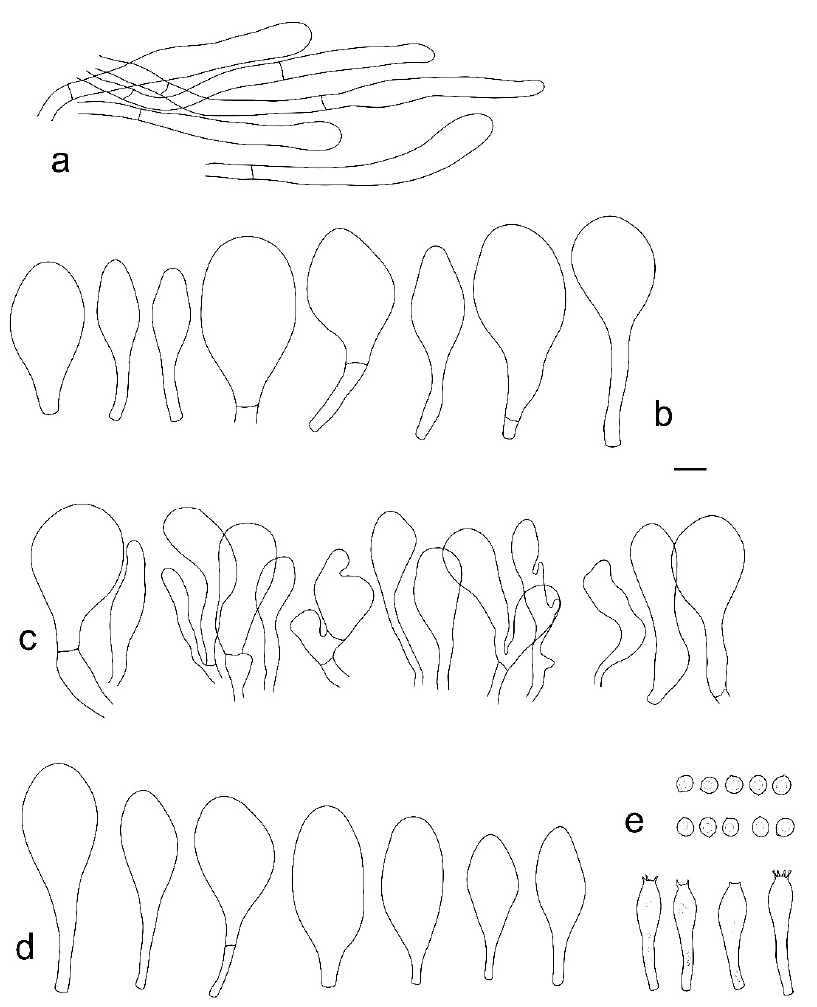
Figure 11. Pluteus assimilatus LE 313452 holotype: ( a ) caulocystidia; ( b ) cheilocystidia; ( c ) pileipellis elements; ( d ) pleurocystidia; ( e ) basidia and spores. Scale bar 10 µm.